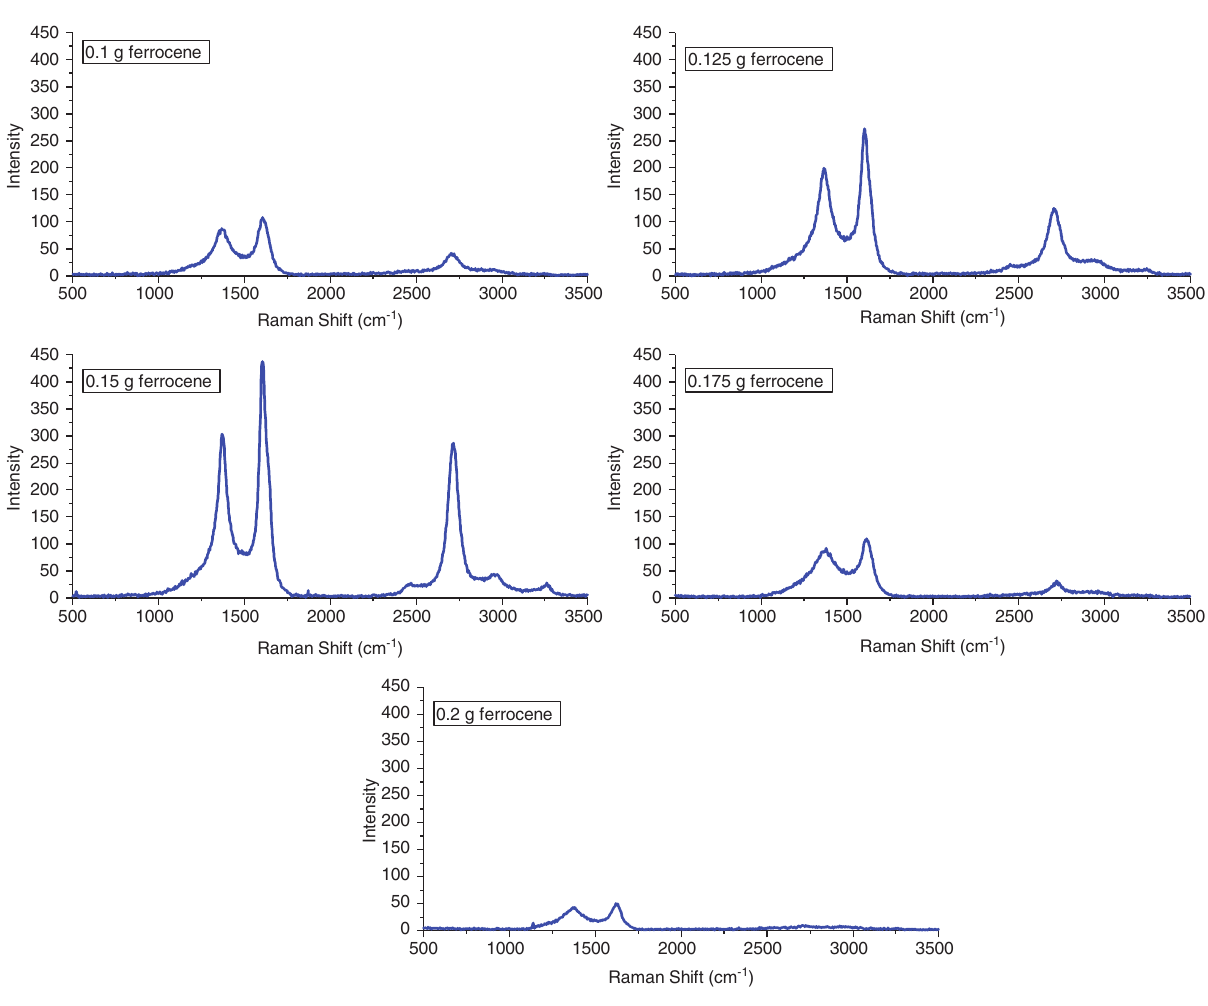
Figure 4: Raman spectra of MWCNTs grown with different weights of ferrocene.